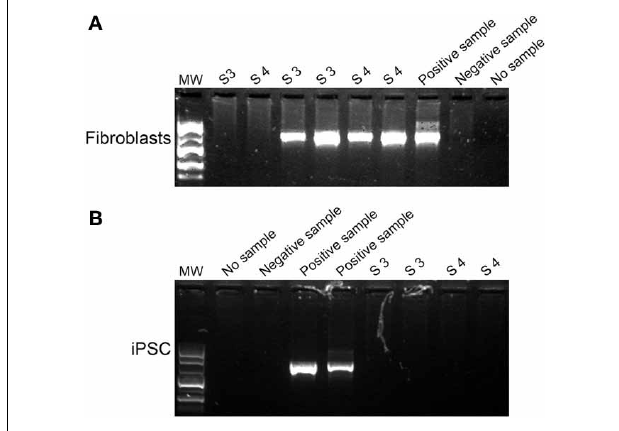
FIGURE A1 | Treatment of mycoplasma-infected fibroblasts with BM-Cyclin. The fibroblast culture medium from fibroblasts (A) and iPSCs (B) was analyzed for the presence of mycoplasma DNA using PCR before (A) and after (B) treatment for 20 days with BM-Cyclin.